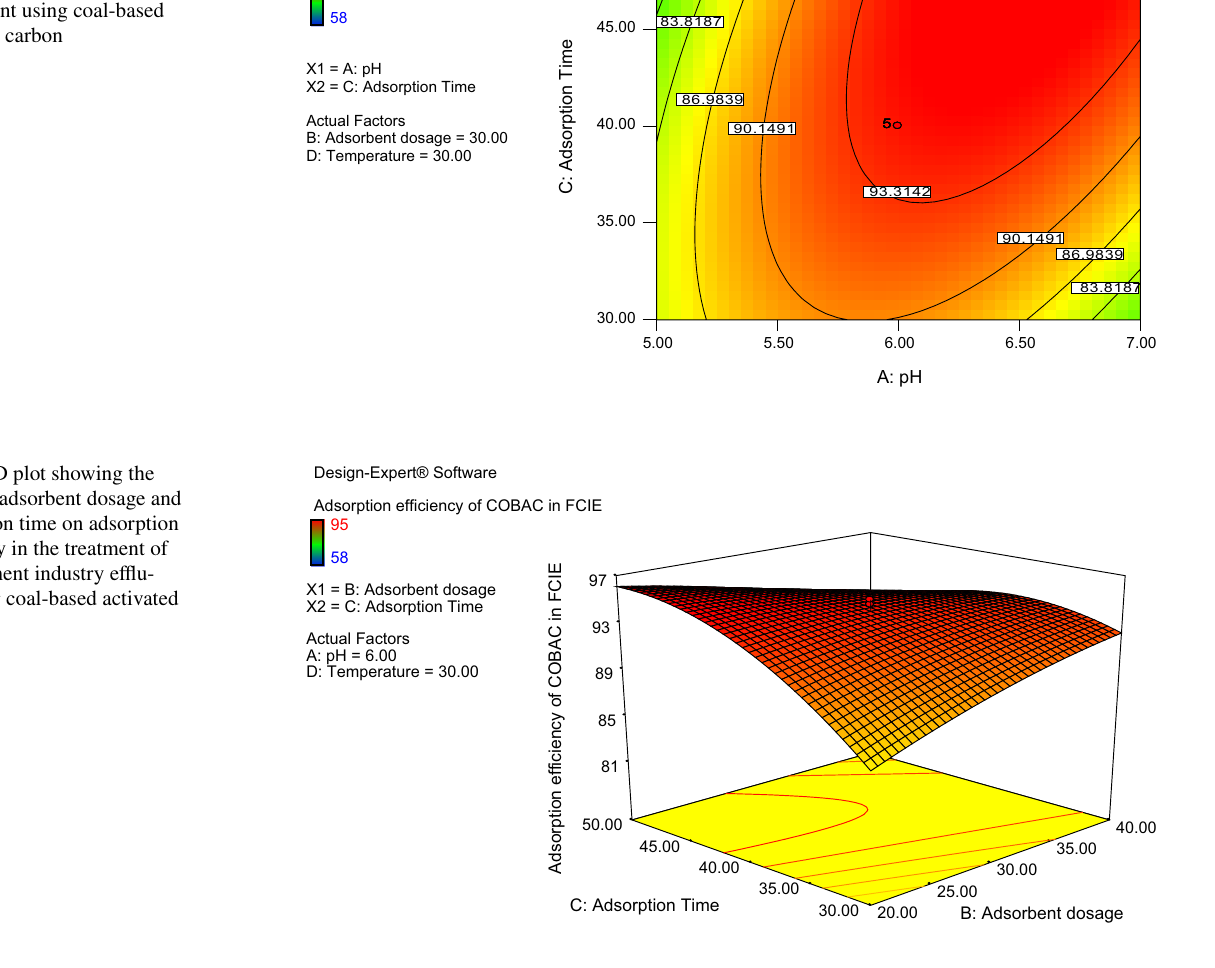
Fig. 6 Contour plot showing the effect of pH and adsorption time on adsorption efficiency in the treatment of fibre cement indus- try effluent using coal-based